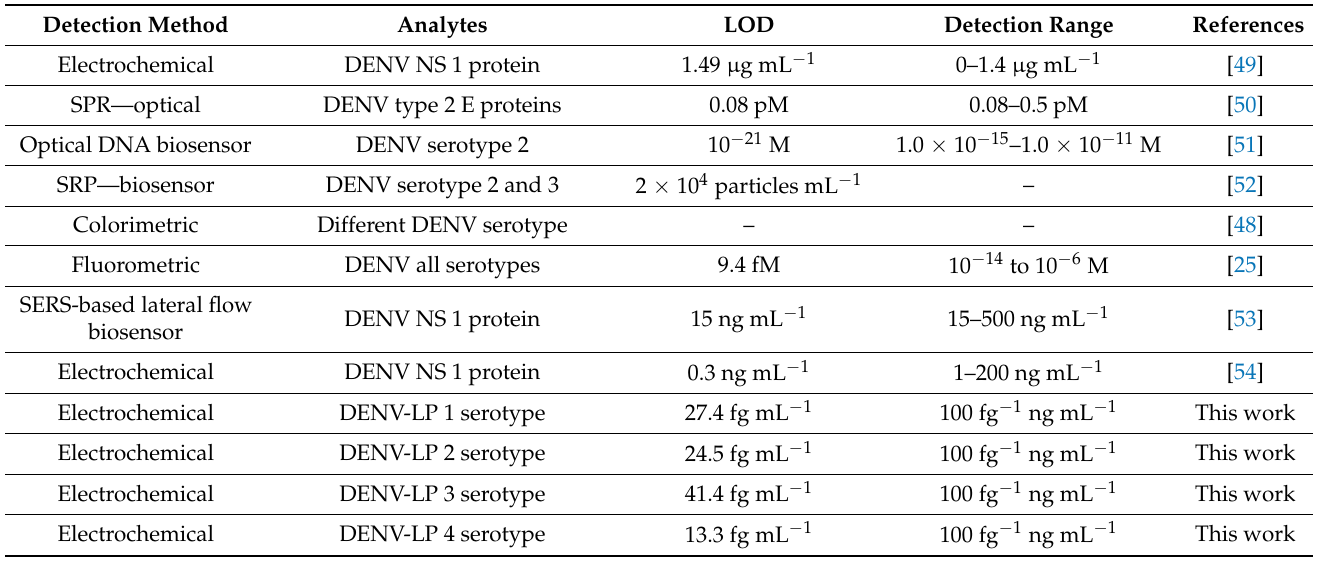
Table 1. Comparison of the detectability of the proposed sensor with recently reported DENV sensors. Detection